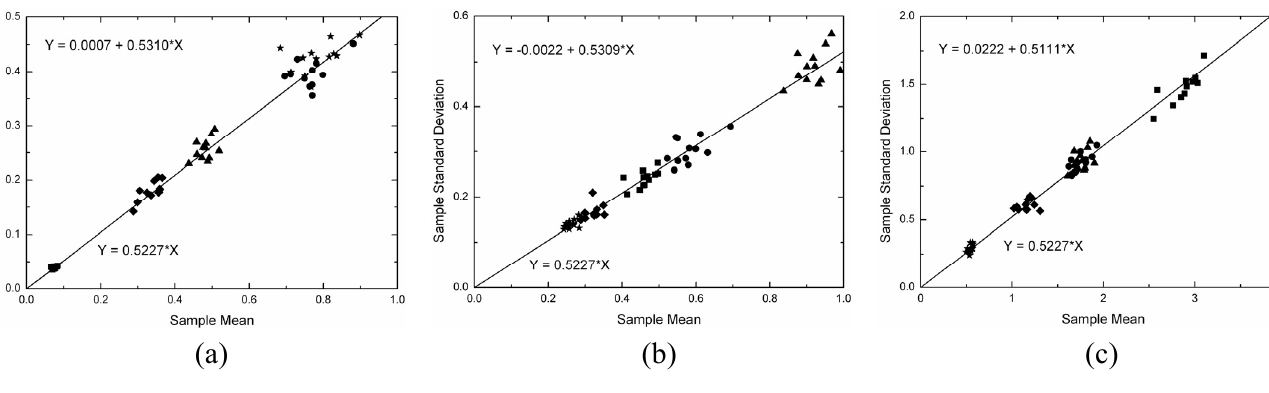
Figure 16. Linear fit to C-band sample data: (a) HH, (b) HV and (c) VV